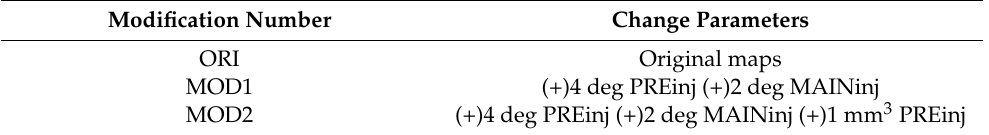
Table 3. Numbering of the changes carried out.